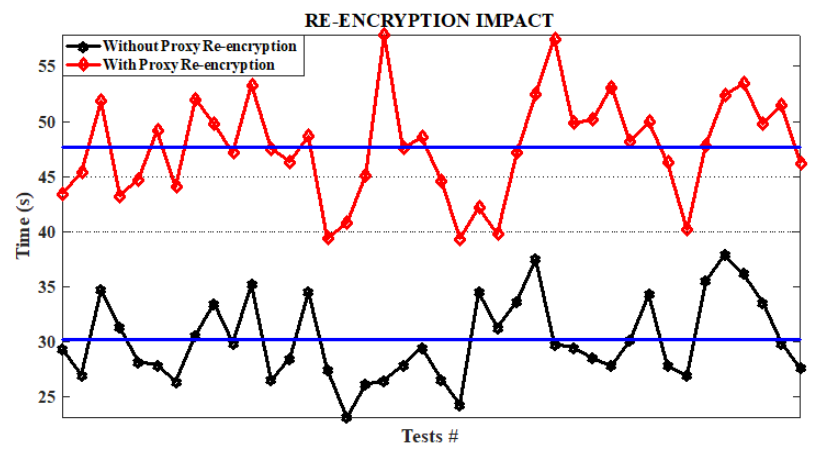
Figure 4. Impact of proxy